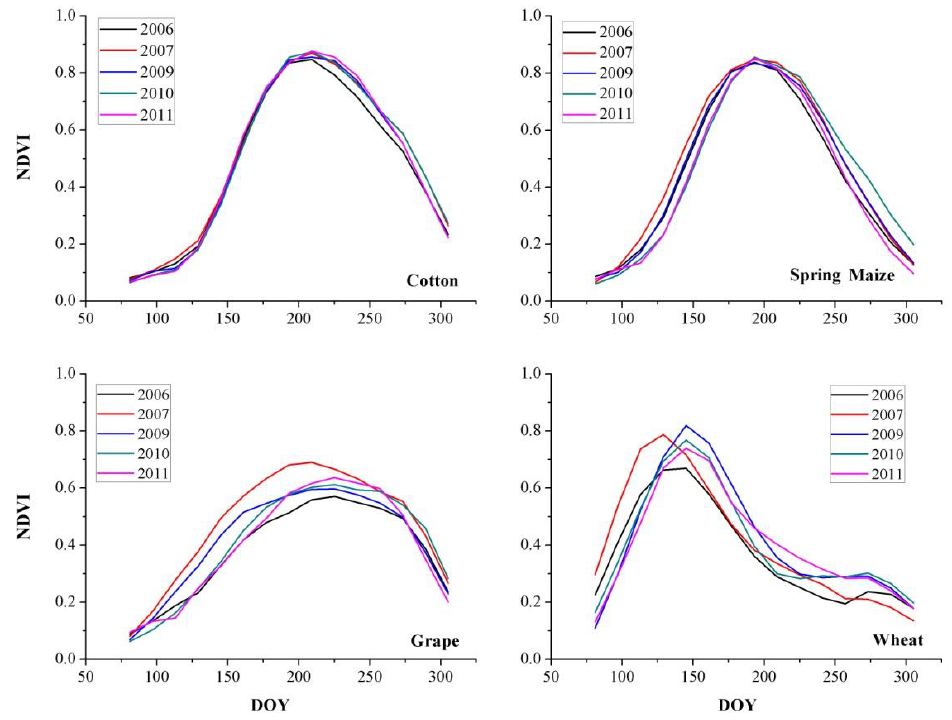
Figure 10. Comparison of inter-annual variation of historical MODIS NDVI time series averaged in Bole and Manas.